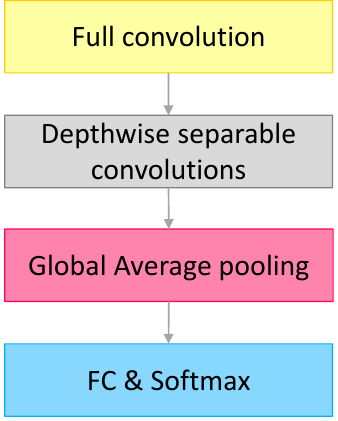
Figure 4. The architecture of the baseline MobileNet